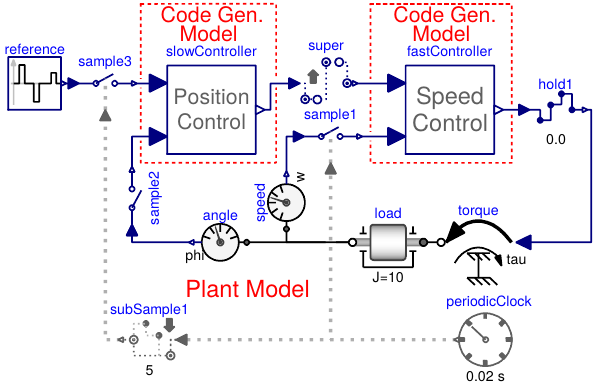
Figure 12: Multirate cascaded control